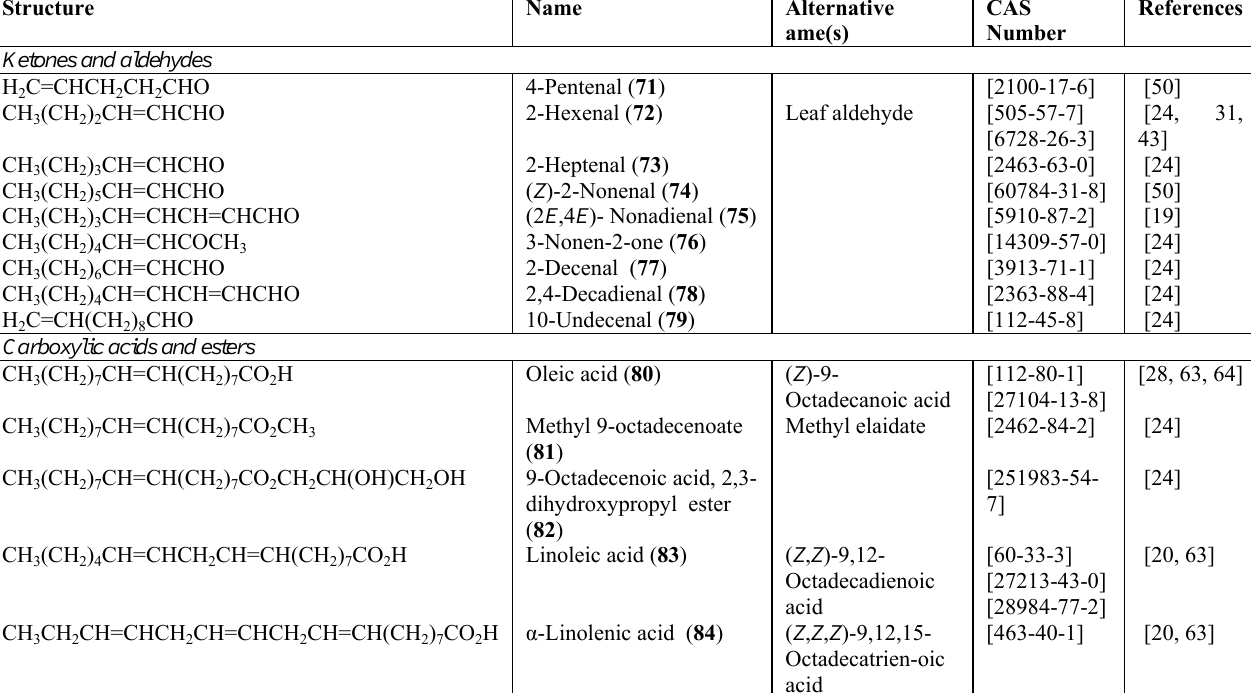
Table 5. Unbranched Alkenic Ketones, Aldehydes, Carboxylic acids and Esters.